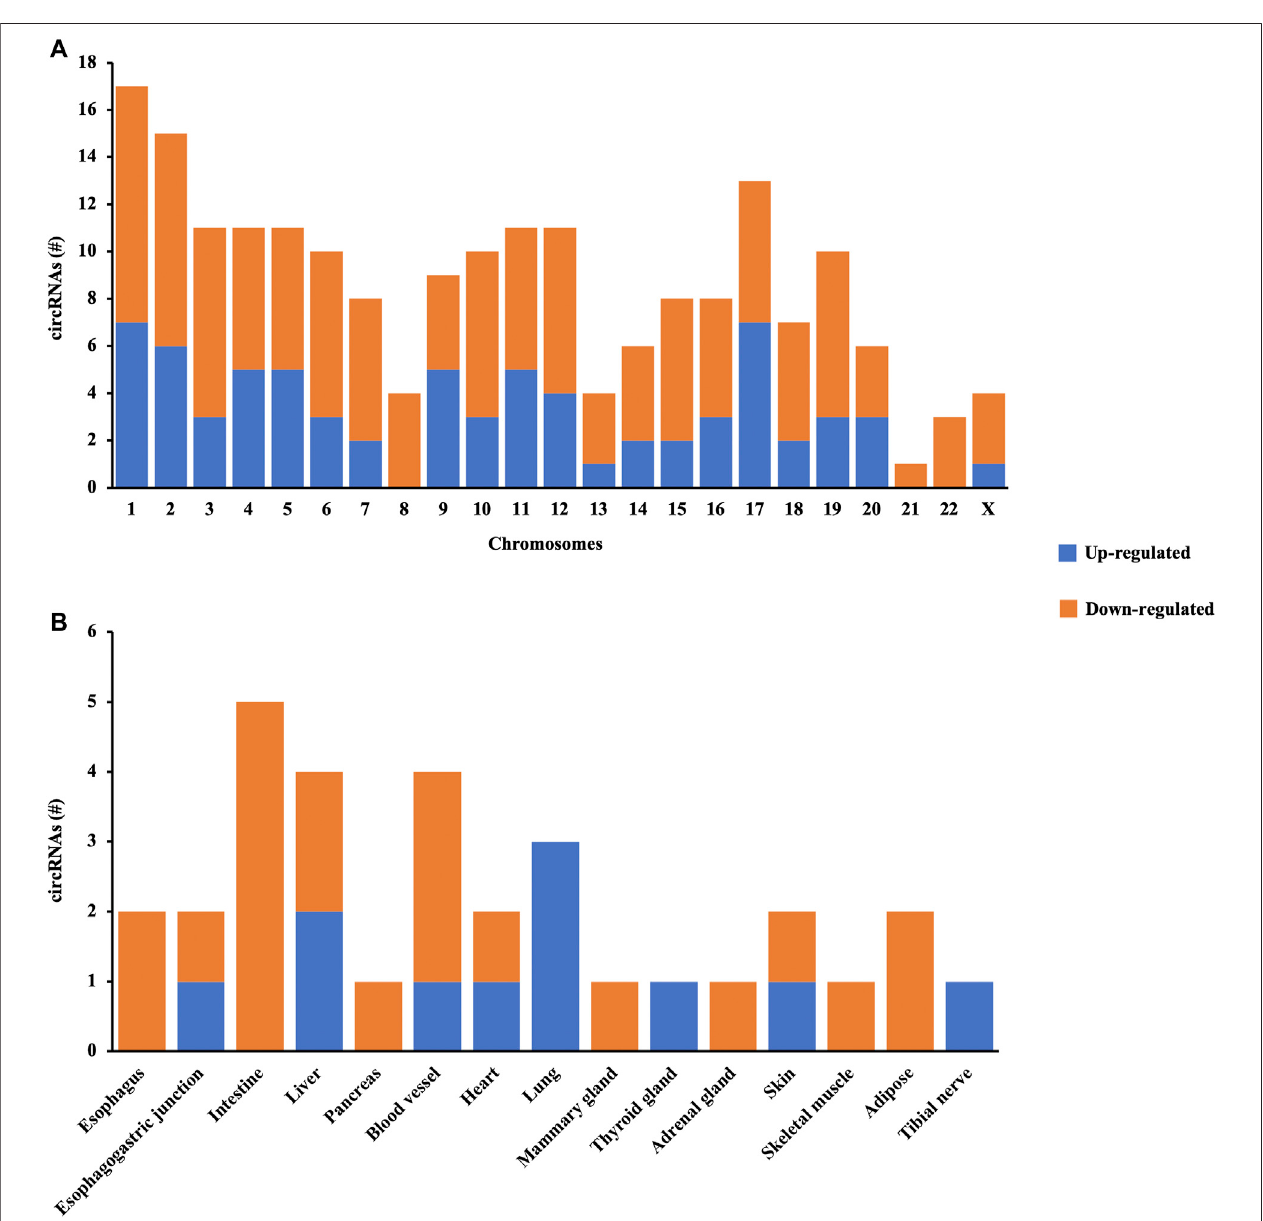
FIGURE 3 | Characterization of circRNA pro fi les between AIS patients and controls. (A) Bar diagram of the distribution of differentially quanti fi ed circRNAs in different chromosomes. (B) Top 15 tissue-speci fi c distributions of differentially quanti fi ed circRNAs.